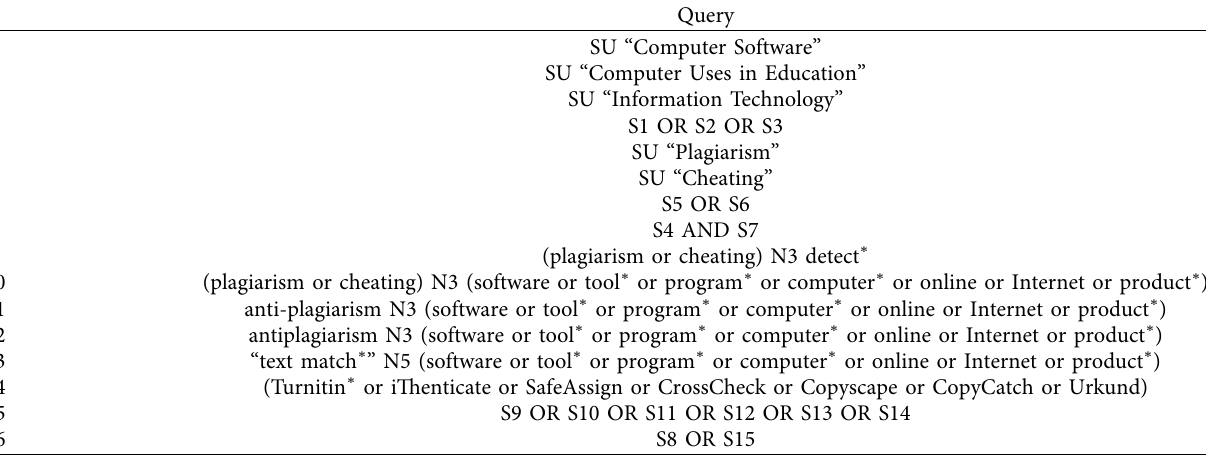
Table 1: ERIC (Ebsco) search strategy.